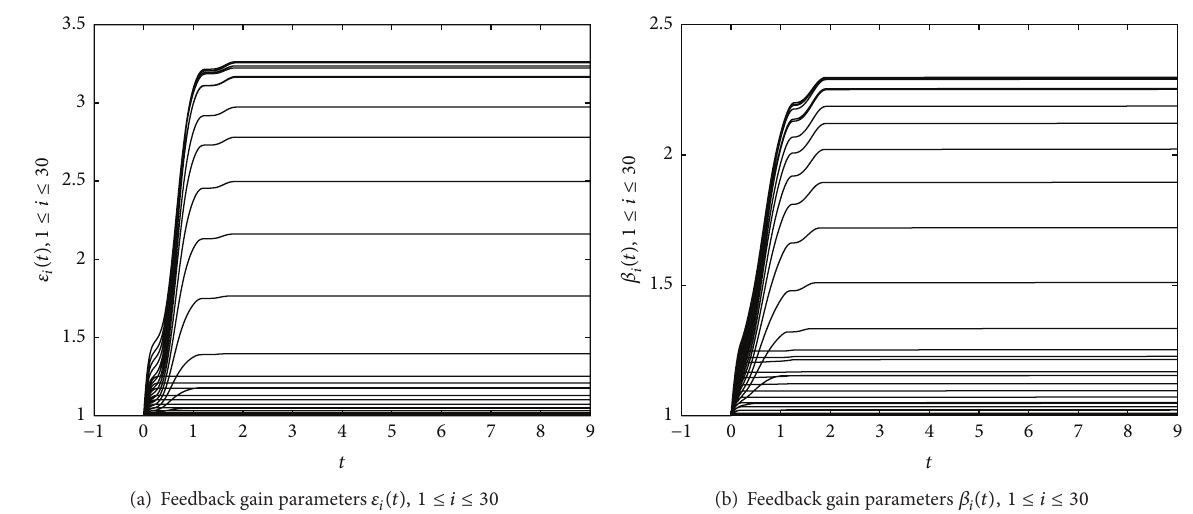
Figure 10: Feedback gain parameters 𝜀 𝑖 (𝑡) (a) and 𝛽 𝑖 (𝑡) (b) (1 ≤ 𝑖 ≤ 30) of (39) with controller